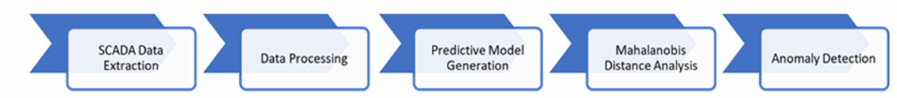
Figure 2. Flowchart used in the